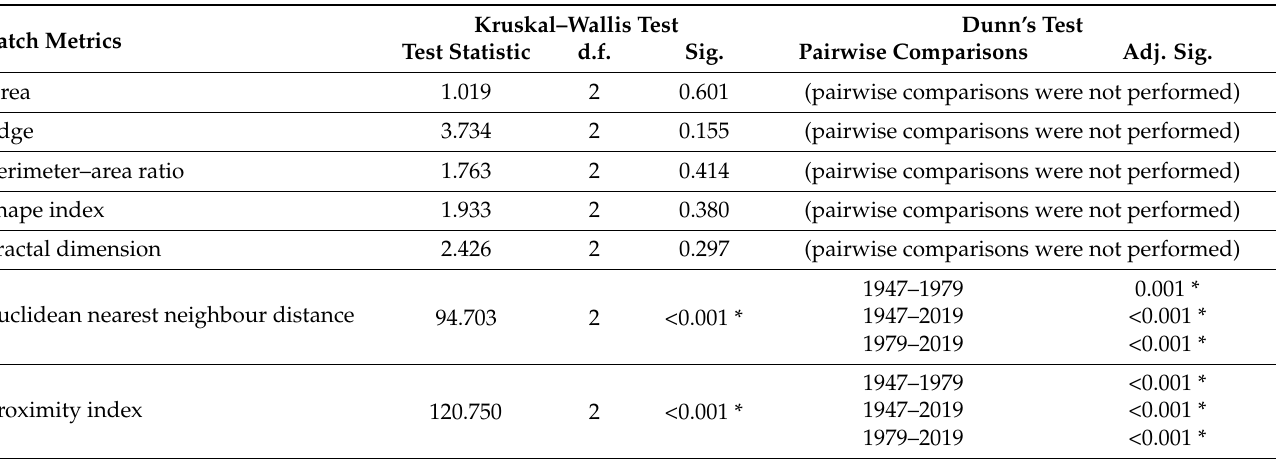
Table 4. Outputs of the Kruskal–Wallis test (and post hoc pairwise comparisons) on patch metrics, considering the analysis for the ABE class (N = 363; significance values for Dunn’s test were adjusted by the Bonferroni correction for multiple